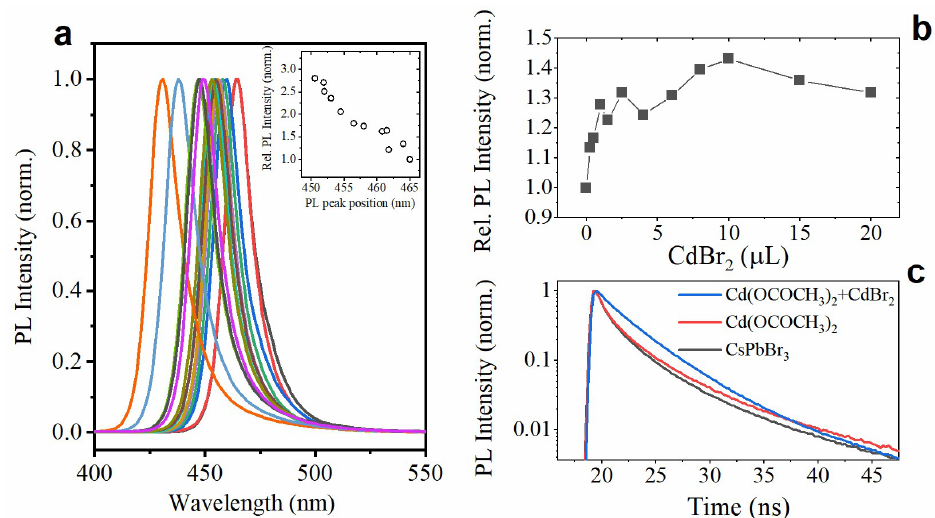
Figure 4. ( a ) PL spectra of Cd 2+ -doped NPls with various amounts of Cd(OCOCH 3 ) 2 precursor solution. The inset shows the dependence of PL QY on the PL peak position. ( b ) Relative PL intensity of the NPls doped with Cd(OCOCH 3 ) 2 (PL peak position at 455 nm) after the addition of various amounts of CdBr 2 . ( c ) PL decay curves taken for the undoped NPls (black line), doped with Cd(OCOCH 3 ) 2 (red line), and CdBr 2 treated after Cd(OCOCH 3 ) 2 doping (blue line).